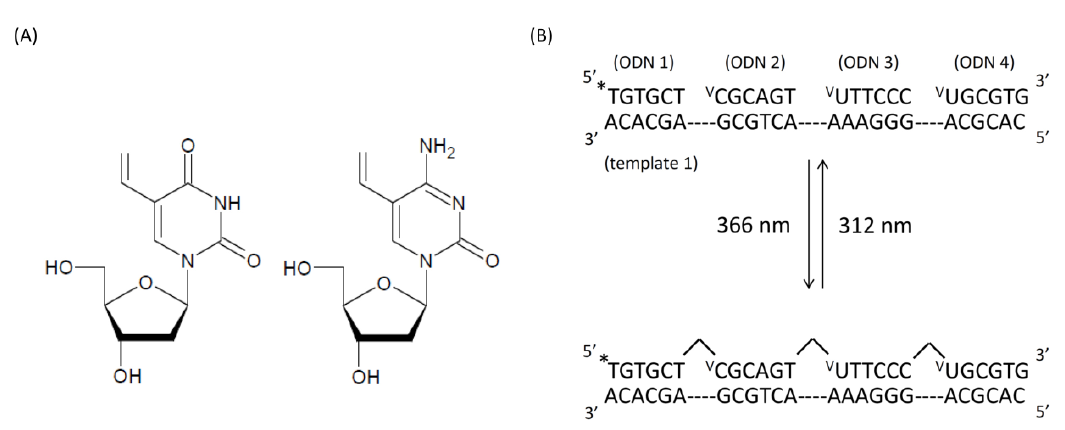
Figure 1. ( A ) Chemical structure of V U and V C nucleoside; ( B ) Schematic illustration for reversible photoligation with V U and V C. *: 32 P label.